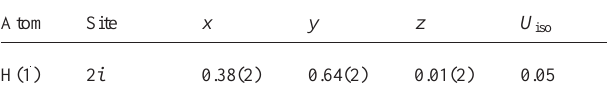
Table 2. Atomic coordinates and displacement parameters (in Å 2 )